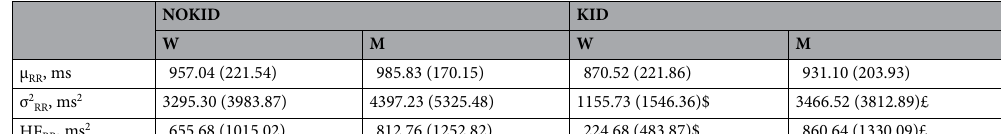
NOKID KID W M W